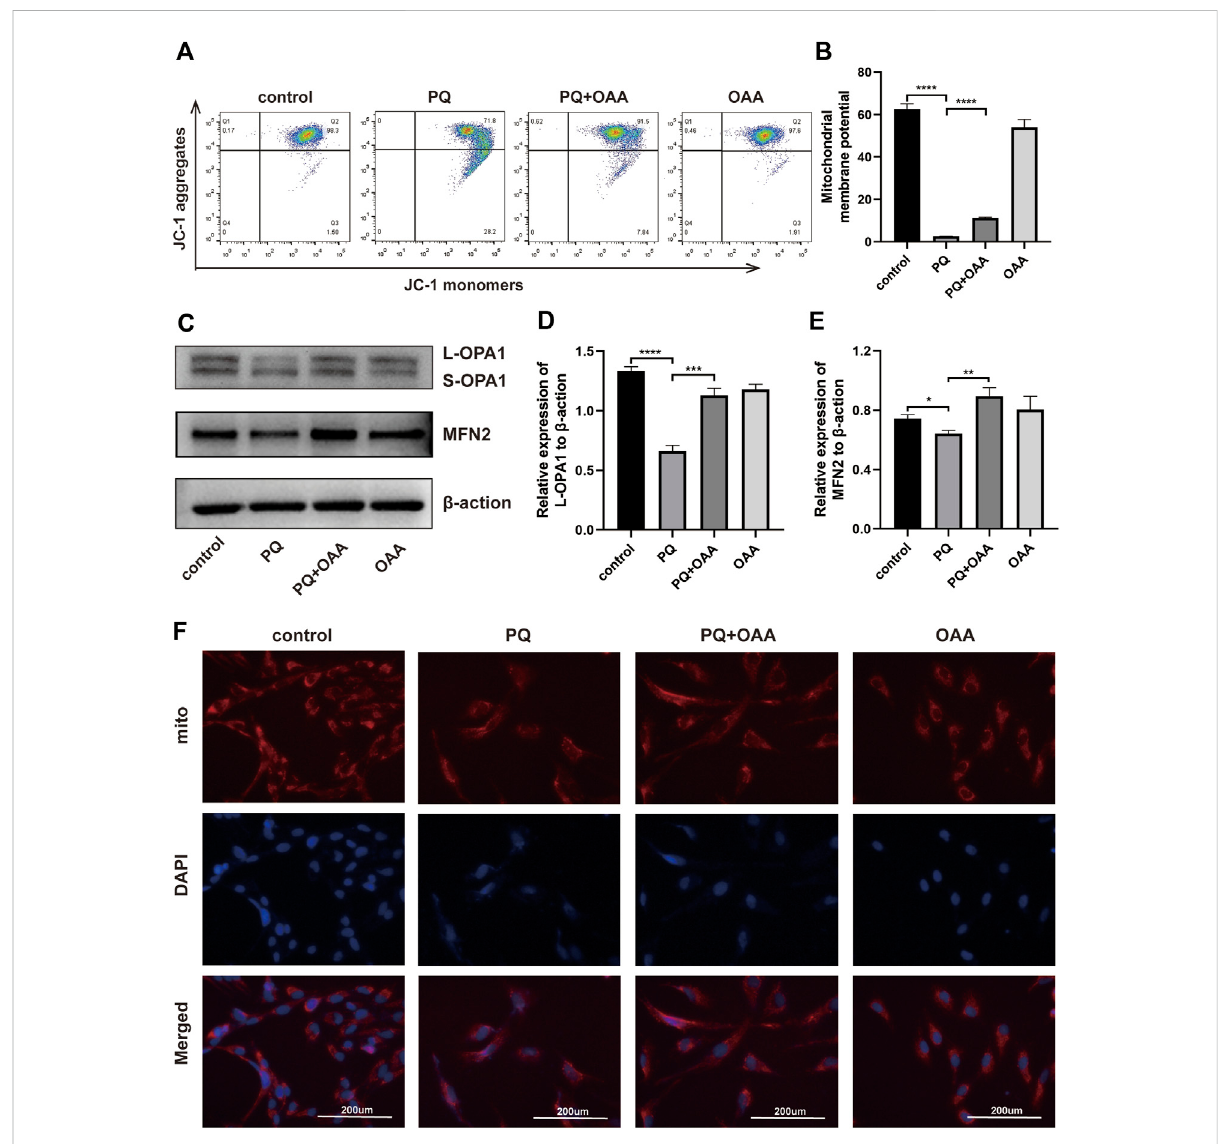
FIGURE 4 OAA improves PQ-induced mitochondrial function in B2B cells. (A,B) After JC-1 staining, MMP was determined by fl ow cytometry. (C – E) The expression levels of L-OPA1, S-OPA1 and MFN2 protein was detected by WB assay. (F) After MitoTracker staining, the changes in mitochondrial dynamics were detected by immuno fl uorescence. Mitochondrial stained with MitoTracker (red) and nuclei were stained with DAPI (blue). Data are presented as mean ± SD ( n = 3). * p ＜ 0.05, ** p ＜ 0.01, *** p ＜ 0.001, **** p ＜ 0.0001.PQ, paraquat; OAA,oxaloacetate acid; mito,